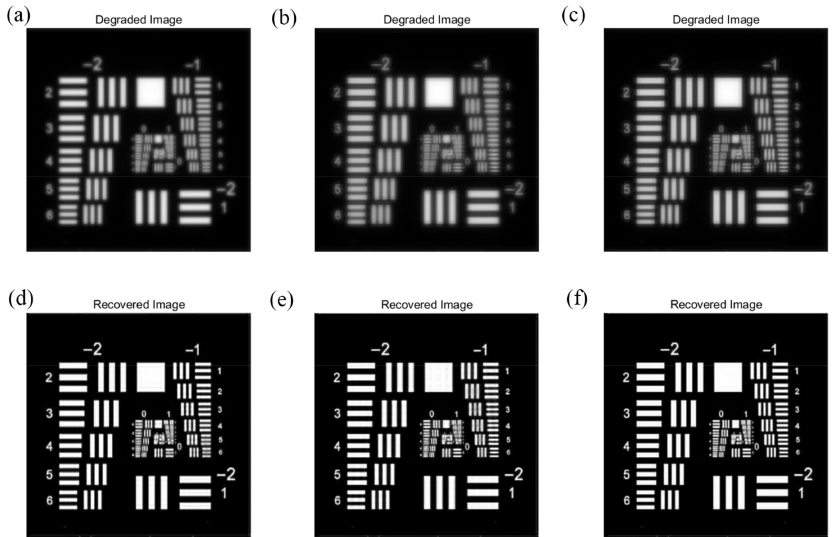
Figure 10. ( a – c ) The degraded images of the SAMs with structures of Golay3, Annulus and Cross, respectively. ( d – f ) The recovered images of the SAMs with structures of Golay3, Annulus and Cross,